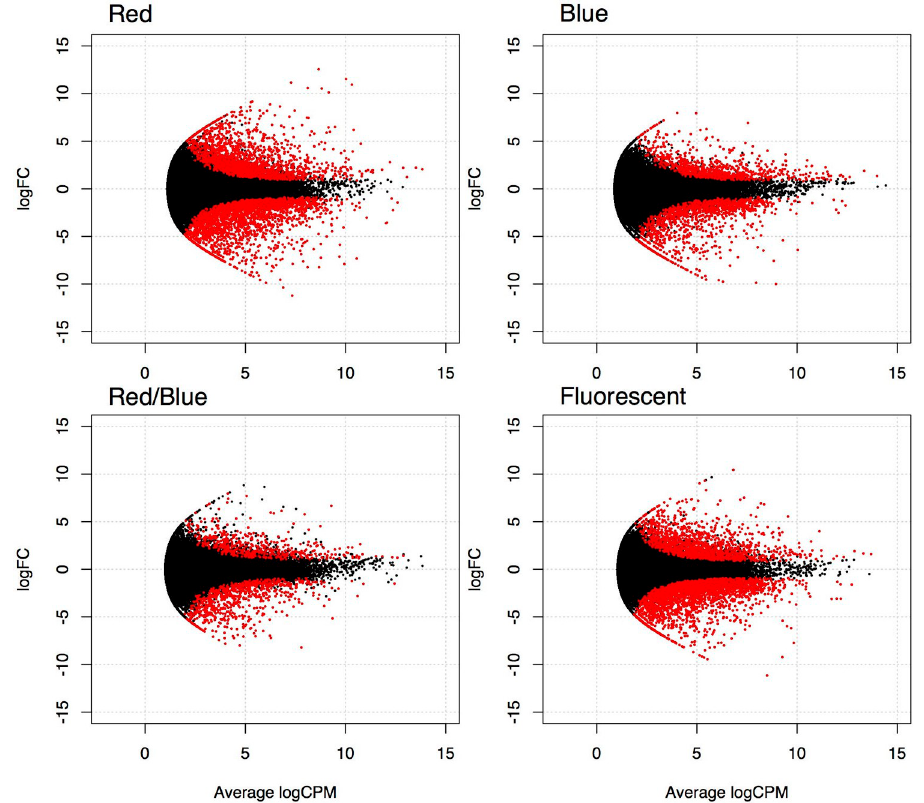
Fig 3. MA plots for different light source conditions. Relationships of the log 2 fold change (FC) and the average of log 2 counts per million (CPM) between the young and old leaves of lettuce plants grown under the four light source conditions. Genes differentially expressed between the developmental stages (FDR < 1 � 10 − 3 ) are highlighted in